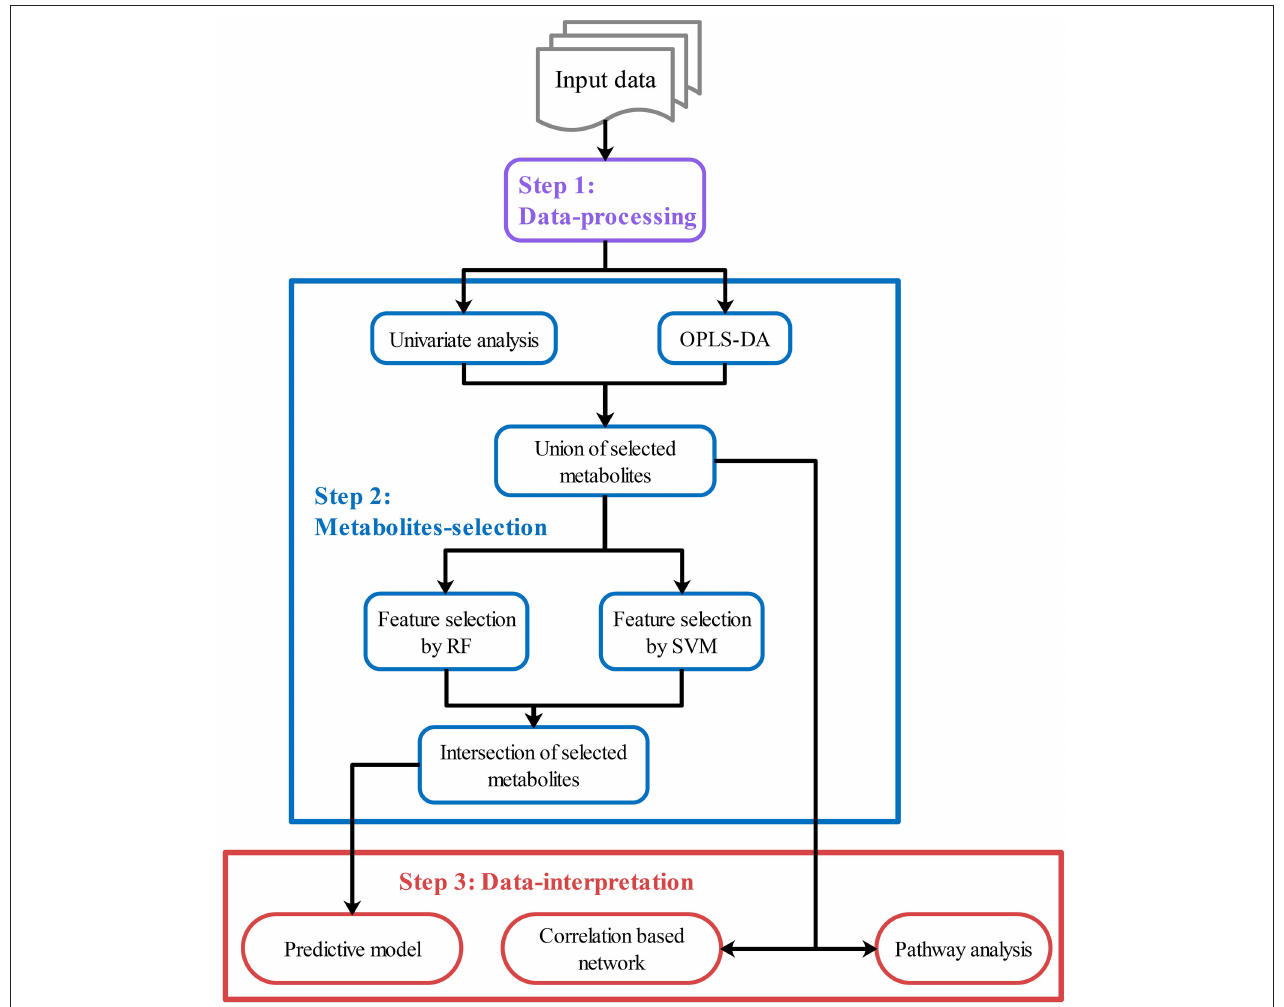
FIGURE 2 | Customized analysis workflows demonstration. Customized workflow is constructed with modules in step 1–3, including data-processing modules (Step 1, purple), metabolites-selection modules (Step 2, blue), and data-interpretation modules (Step 3, red). Users can add/remove/edit/reorder modules in each step. Users can also skip any step if they do not need